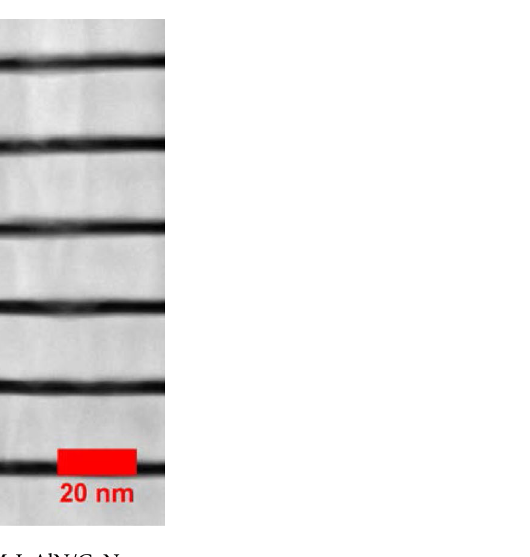
Figure 4. TEM cross sectional images of SSPM-L